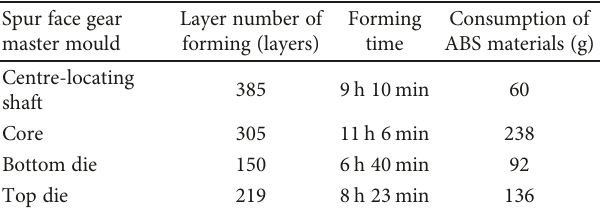
Figure 10: The reasonable ambient temperature range of di ff erent nozzle temperatures. Table 6: Layered slice processing results of each model for spur face gear master